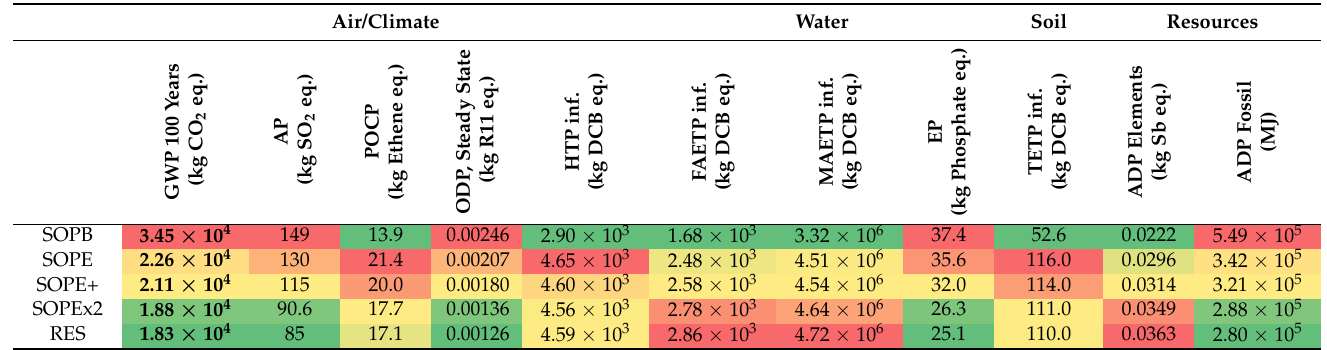
Figure 16. General LCA model adapted for the RES case of the Lizara hut. In Table 6 a comparison of the environmental impact indicators for all the configura- tions is presented. In addition to the values, a color chart (green–orange–red) is used in each impact category to provide an additional visual effect for high (red) and low (green) relative values. Table 6. Comparison of environmental impact indicator values for all the observed configurations in the Lizara hut.